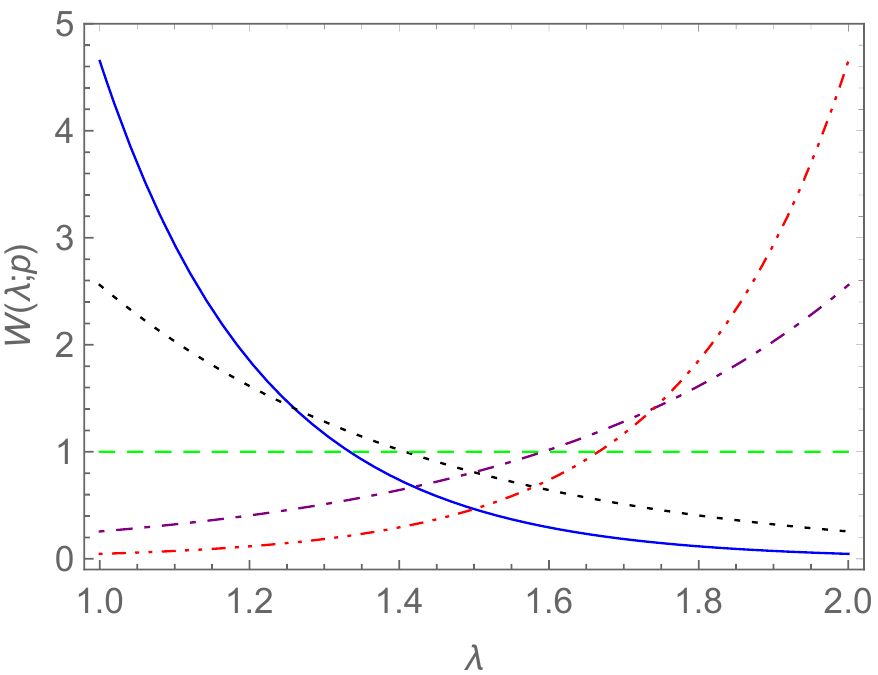
Figure 8. Curves of W ( λ ; p ) versus λ on 1 ≤ λ ≤ 2 when p takes different values: p = 0.01 (solid line), p = 0.1 (dotted line), p = 1 (dashed line), p = 10 (dot-dashed line), and p = 100 (dot-dot-dashed